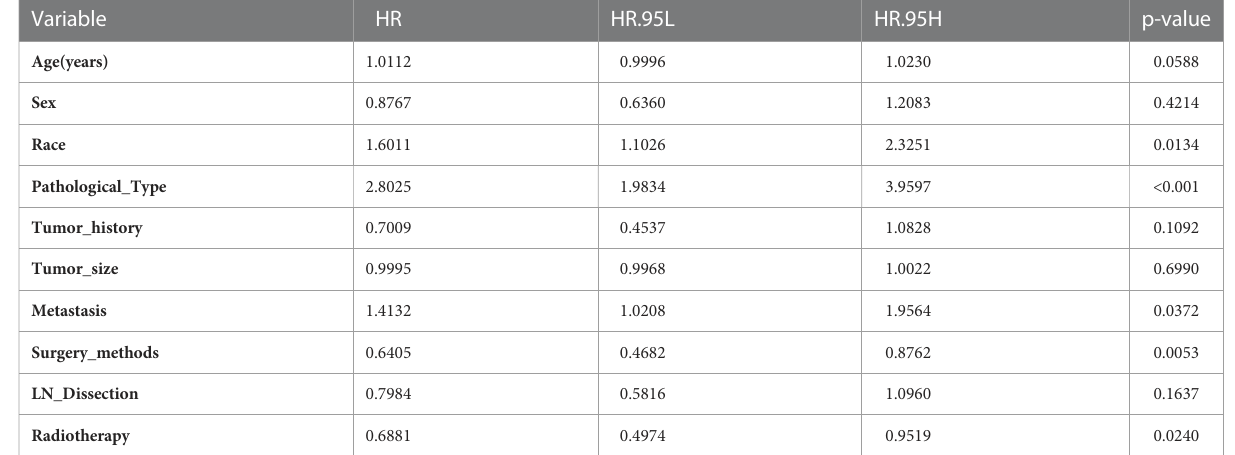
TABLE 4 The results of univariate cox analysis.